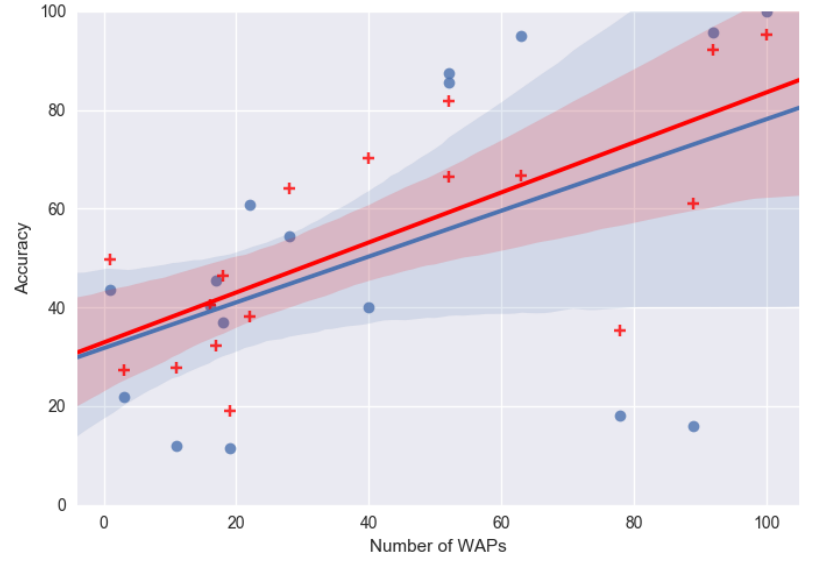
Figure 4. Relationship between the number of WAPs perceived in a scenario and the accuracy measures estimated (see accuracy definitions in Section 5.2). Blue points and the blue line are related to the notification accuracy and the red crosses and red line are related to the test